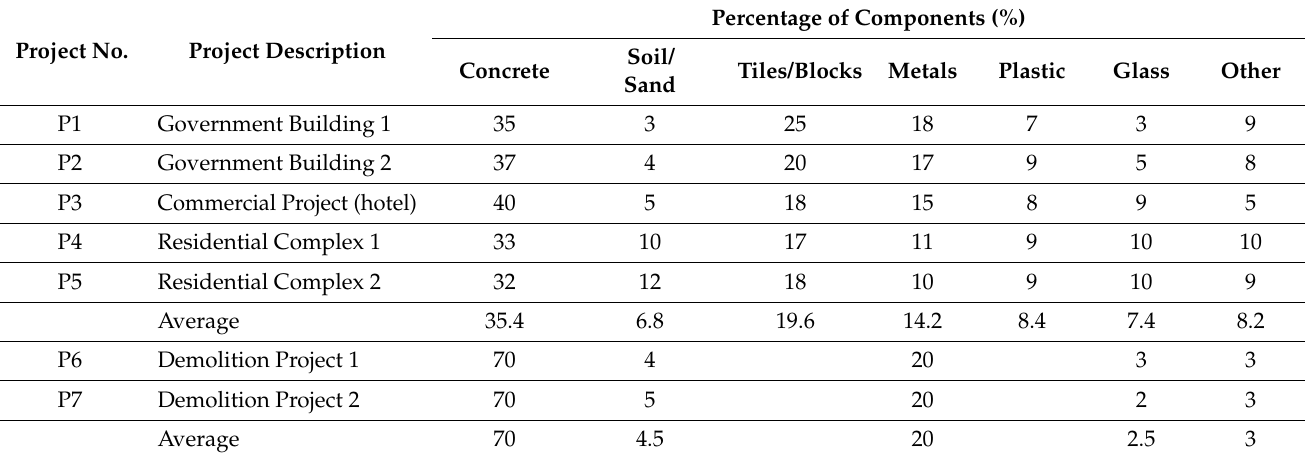
Table 3. Composition of C&D waste at the